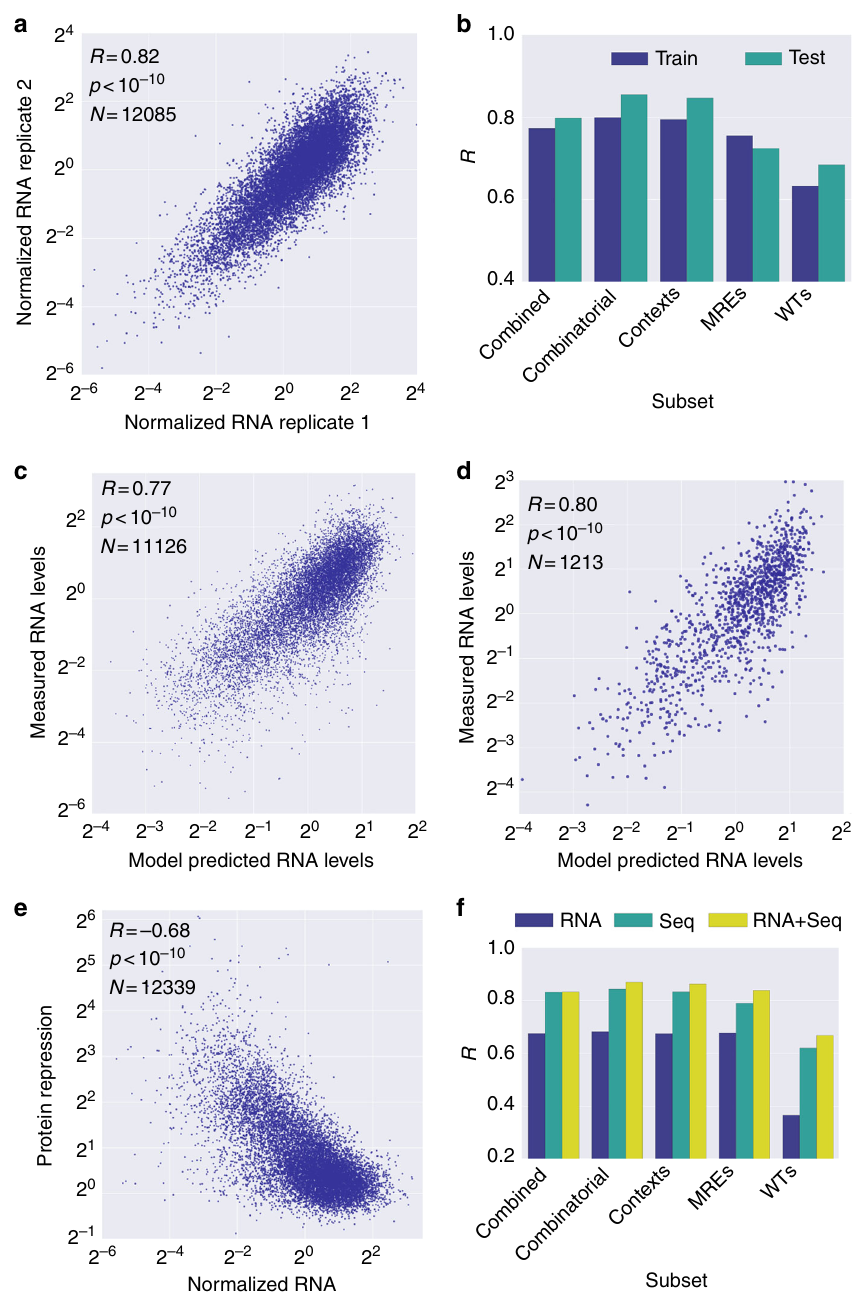
Fig. 6 Incorporation of RNA levels into the model does not signi fi cantly improve model performance. a Scatter plot of RNA level measurement replicates from the genomically integrated reporter library. b Bar plot depicting model performance for predicting the RNA levels on training and test data. c Scatter plot of measured vs model-predicted normalized RNA levels on training data. d Scatter plot of measured vs model-predicted normalized RNA levels on test data. e Scatter plot of measured protein repression levels vs measured normalized RNA expression levels. f Comparison of model performances for predicting protein repression based on different training data. “ RNA ” refers to a model that used measured normalized RNA levels as the single input feature. “ Seq ” refers to the model that used the MRE-based features as in Fig. 5a. “ RNA + Seq ” refers to a model that used both the MRE-based features and the measured normalized RNA levels as input